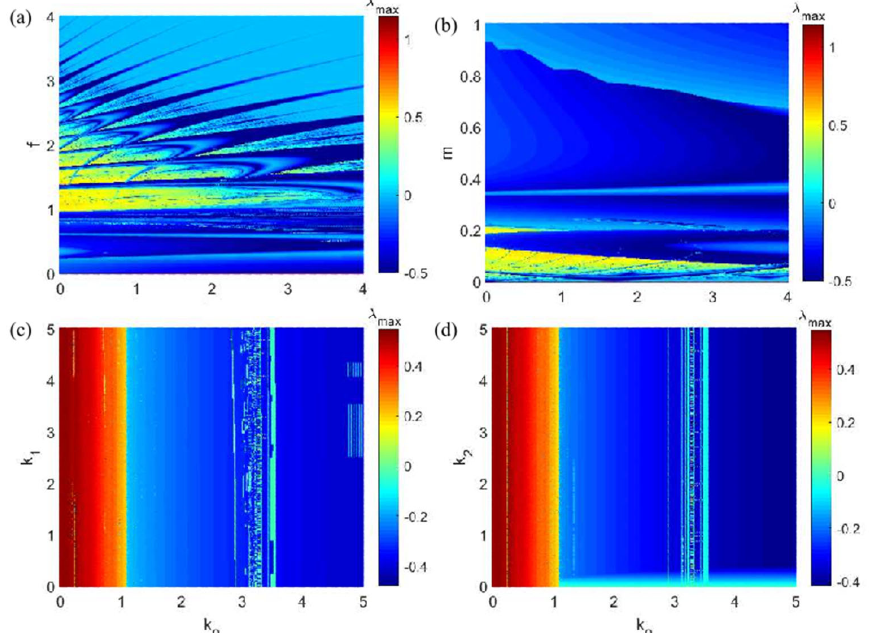
Figure 2. Two ‐ parameter diagrams show the global dynamics of the proposed neuron model when two parameters simultaneously vary. ( a ) The plane (k 0 , f) is obtained for m = 0.2, k 1 = 0.01, and k 2 = 0.5. ( b ) The plane (k 0 , m) is obtained for f = 1.0, k 1 = 0.01, and k 2 = 0.5. ( c ) The plane (k 0 , k 1 ) is obtained for m = 0.2, f = 1.0, and k 2 = 0.5, and ( d ) the plane (k 0 , k 2 ) is obtained for m = 0.2, k 1 = 0.01, and f = 1.0. Initial conditions are [0;0;0].